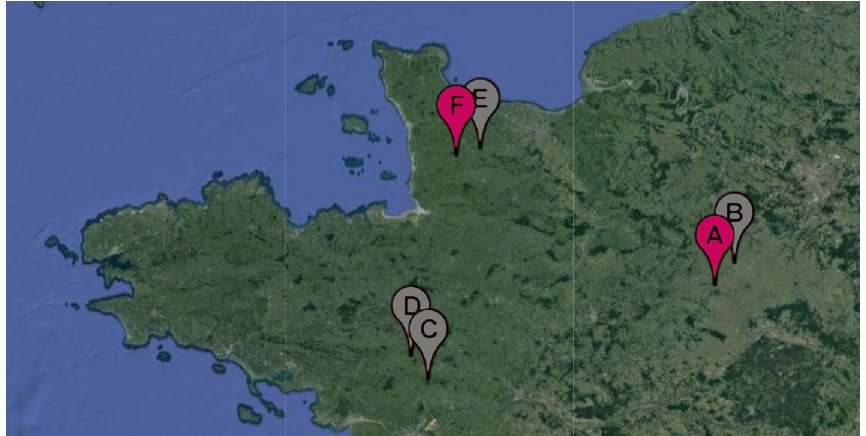
Figure 1. Location of the wind farms owned by Zephyr ENR. There are Parc de Bonneval (A), Moulin de Pierre (B), Parc de Beaumont (C), Parc de la Renardière (D), Parc de la Haute Chèvre (E), and Parc de la Vènerie (F). In this study, results are shown for the two wind farms in red: Parc de Bonneval and Parc de la Vènerie. Figure extracted from Google